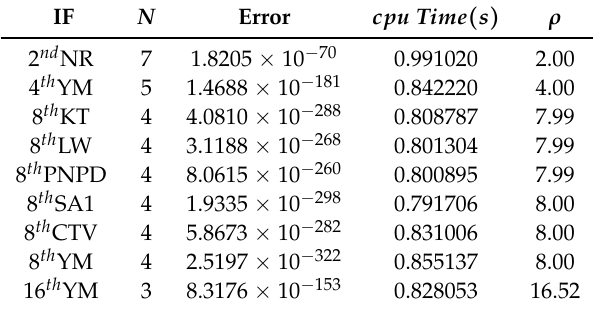
Table 7. Results of Planck’s radiation law